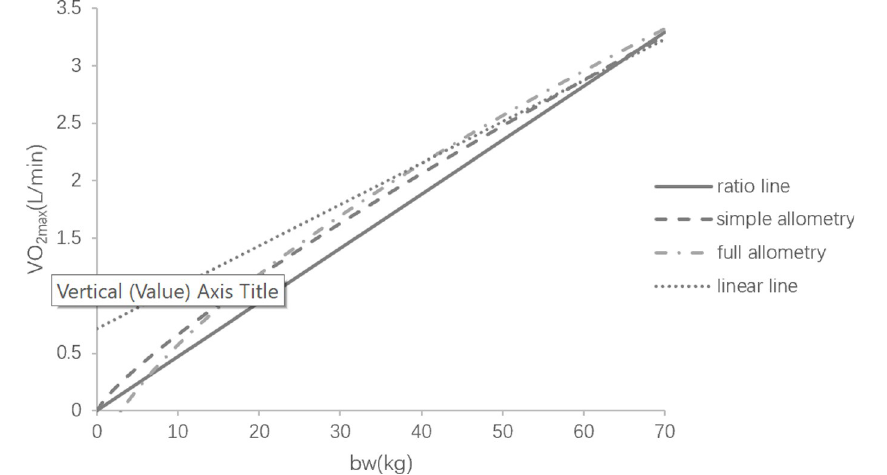
Fig 2. Trends of different models in the interval [0, 70].